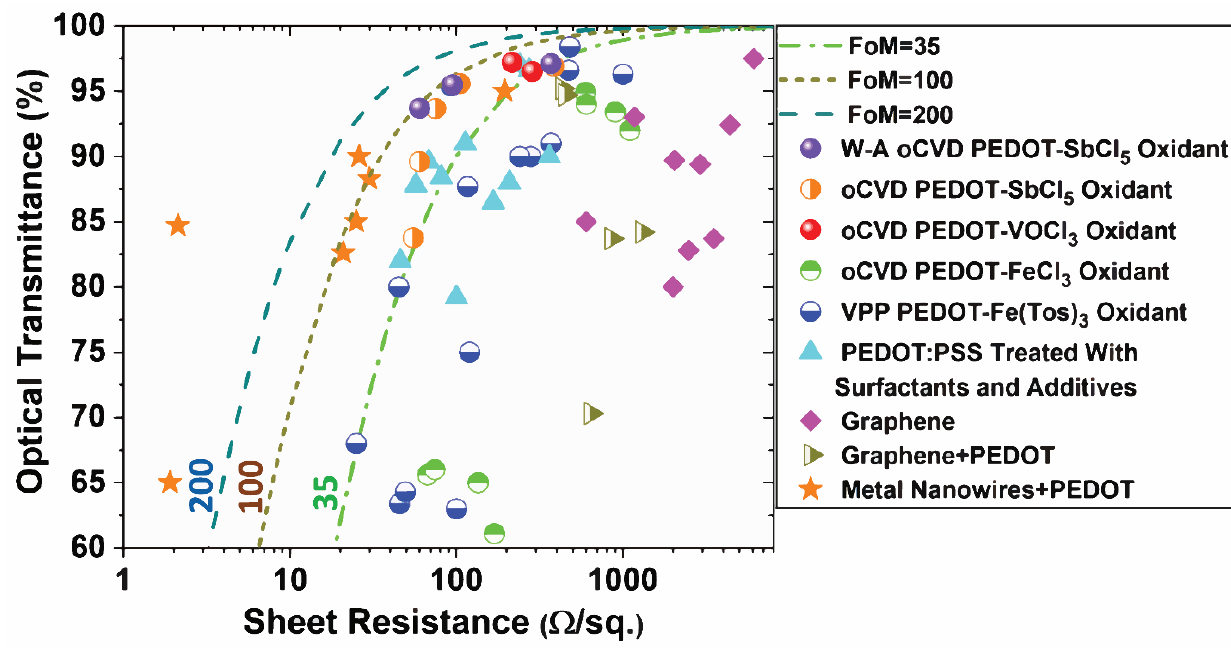
Figure 19. The optical transmittance and related sheet resistance for some categories of flexible transparent conductor electrodes (TCEs) [1,18]. The dotted lines indicate the FoM values of 35, 100, and 200. Reproduced with permission [1,18]. Copyright 2020, Elsevier [1]. Copyright 2020, Wiley [18].